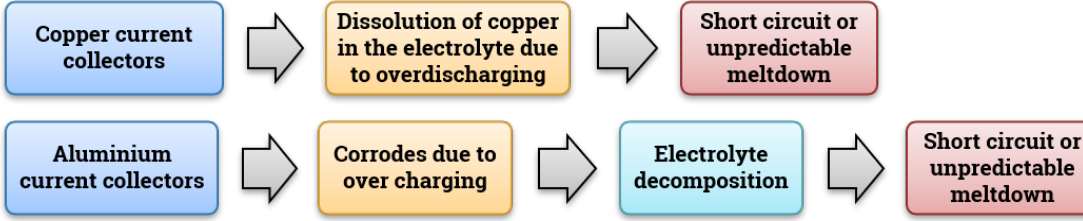
Figure 8. Current collector’s failure mechanism.